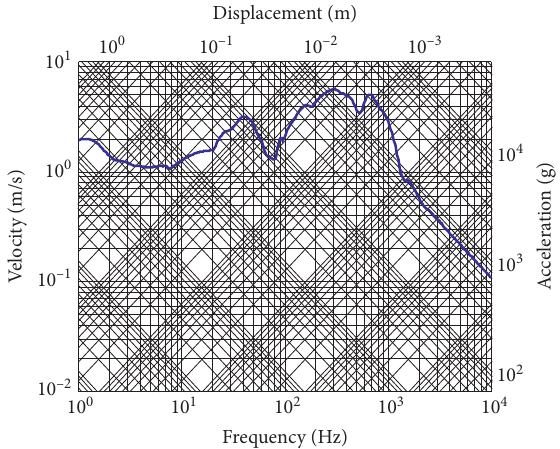
Figure 13: Four-parameter logarithmic shock response